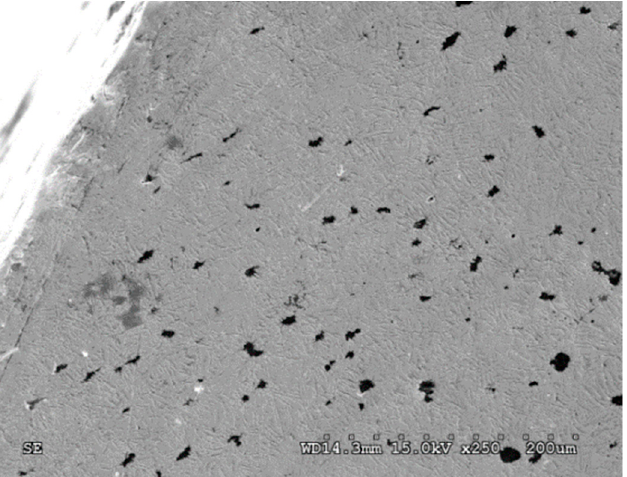
Figure 7. Deformation of the graphite in the surface layer of ADI_360 after abrasive wear (Variant A) (SEM; cross-section).